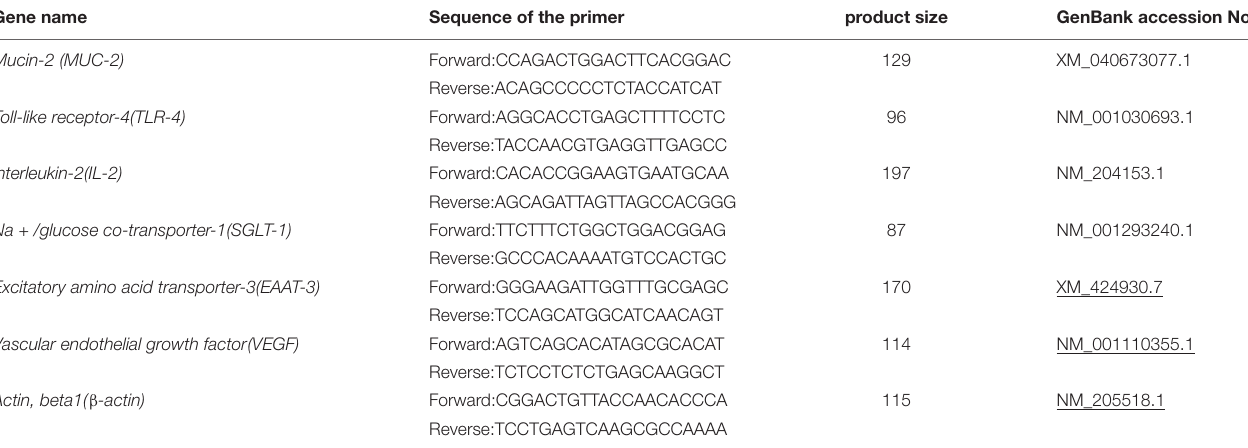
TABLE 2 | Sequences of primers used for relative real-time PCR analysis.